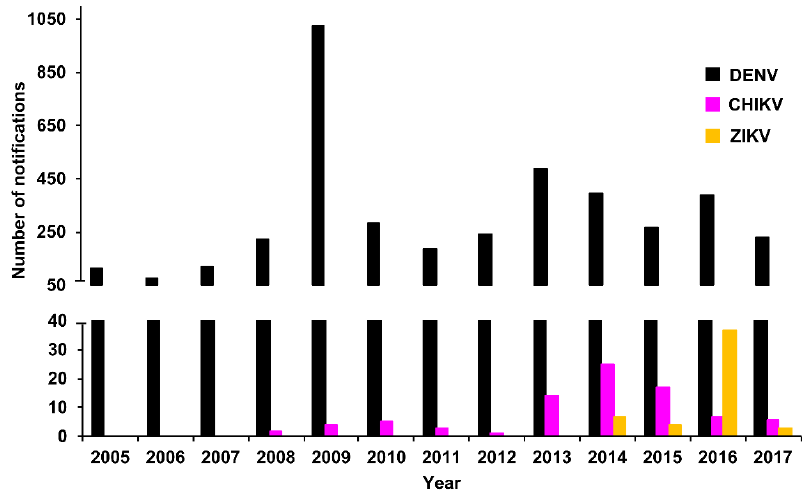
Figure 2. Notified DENV cases by year, Queensland, 2005 – 2017. Number of DENV, CHIKV, and ZIKV